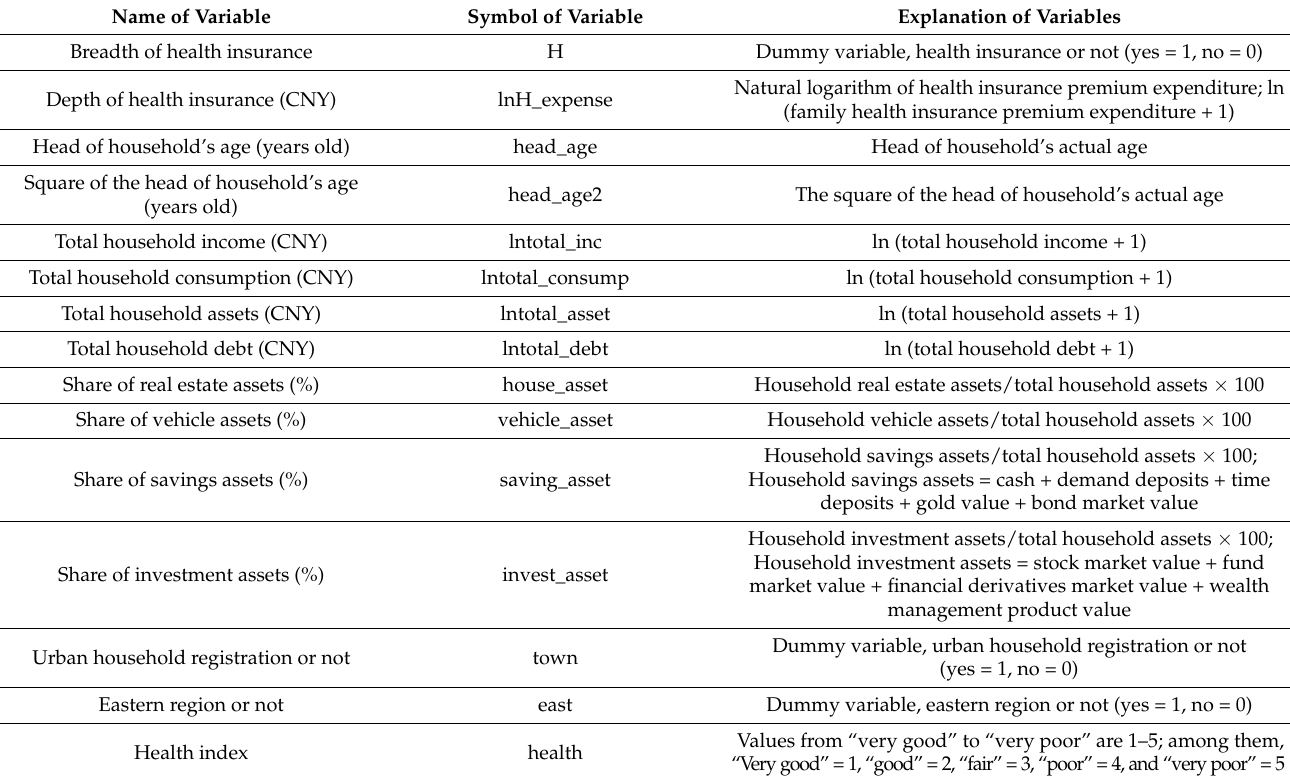
Table 1. Definition of each variable.